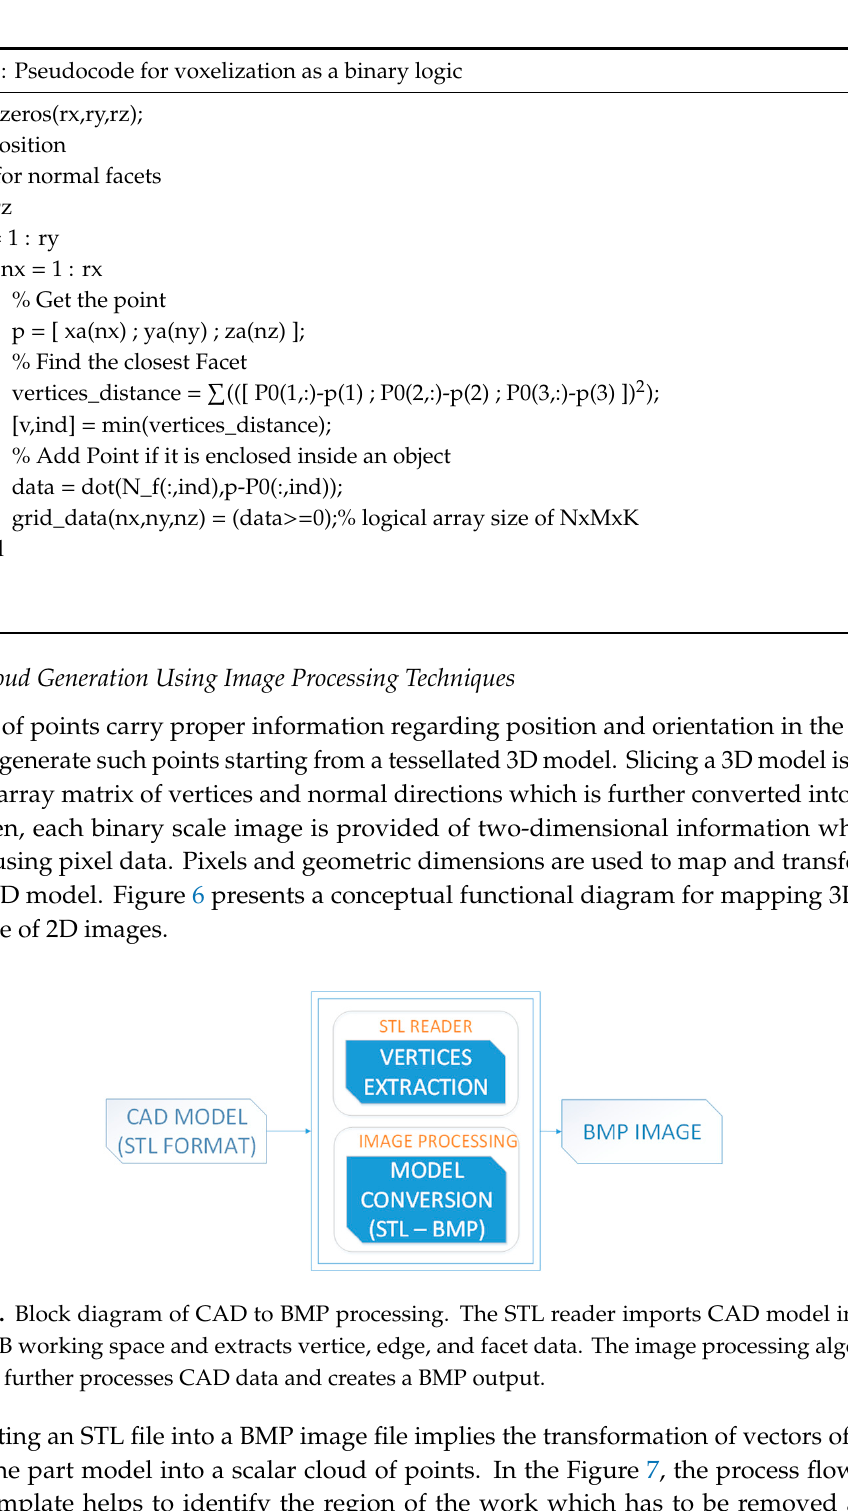
Figure 7. Process flow for CAD model into point cloud processes.